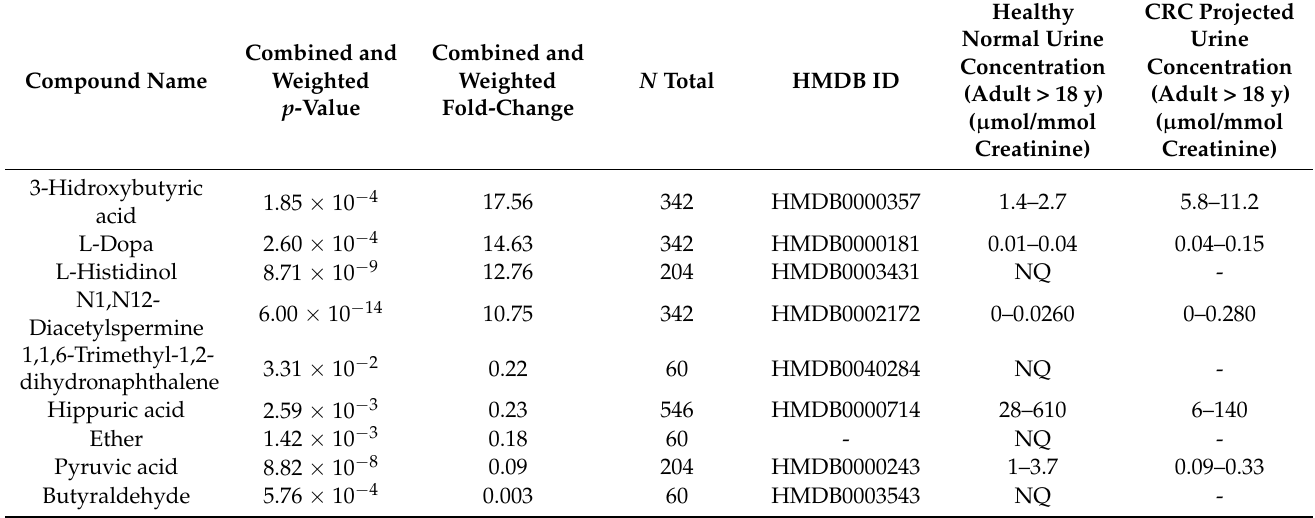
Table 4. Meta-analysis results for the significant compounds in colorectal cancer and advanced adenoma vs. control comparison, including the healthy normal urine concentrations (extracted from the human metabolome database) and the projected colorectal cancer concentrations in urine. NQ: not quantified in